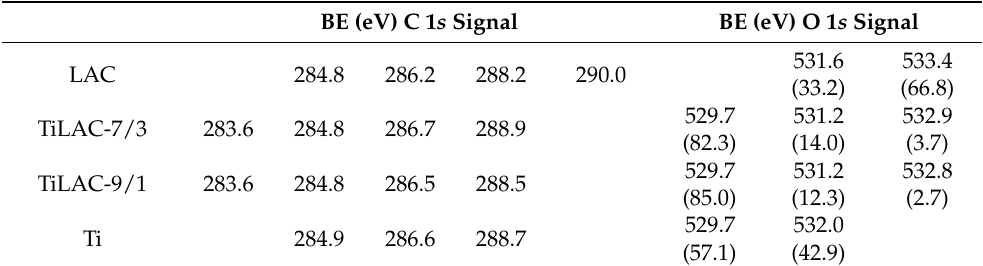
Table 2. BE values corresponding to C 1s and O 1s signals (the relative contribution, in percentage, for the oxygen deconvoluted peaks appears in brackets).